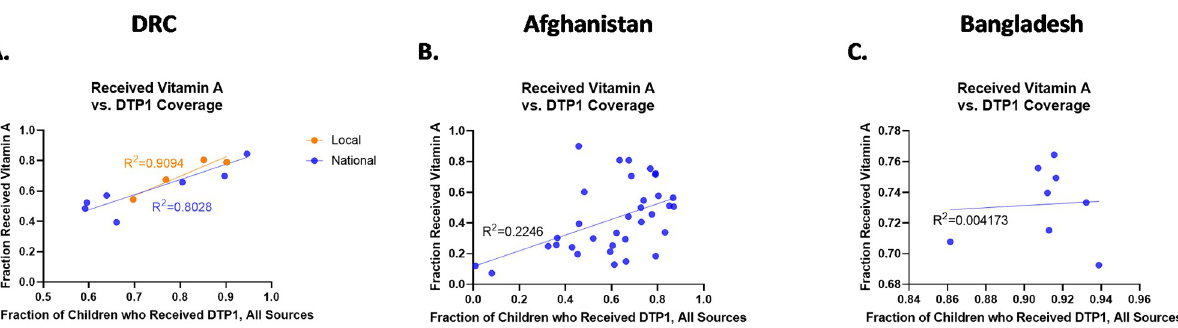
Fig 4. Linear association between DTP1 coverage and vitamin A supplementation in DRC (A), Afghanistan (B) and Bangladesh (C). This association was seen in the local and national data sets in DRC (A). In Afghanistan (B), the association was weaker, producing an R 2 indicating a weak association (R 2 = 0.22). However, the data set for Bangladesh (C) showed no linear association, appearing to be nearly perfectly separate, dissociated variables (R 2 =